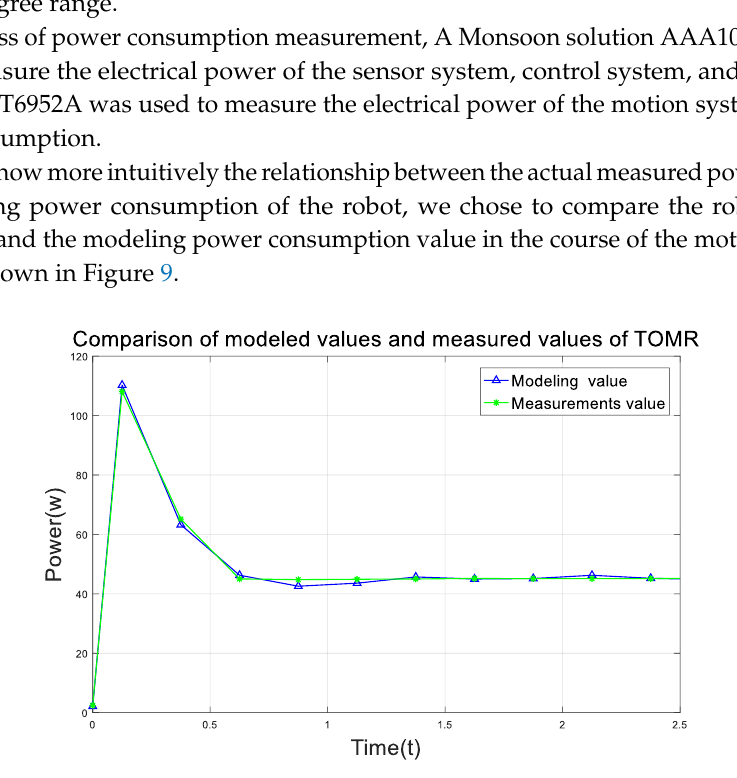
Figure 9. Power measurement and modeling of TOMR.